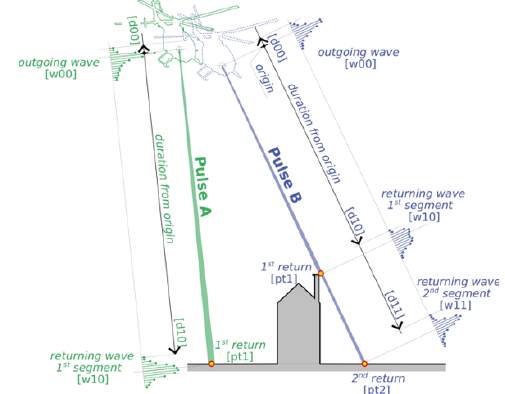
Figure 6. Examples of single segment and multiple segment LiDAR